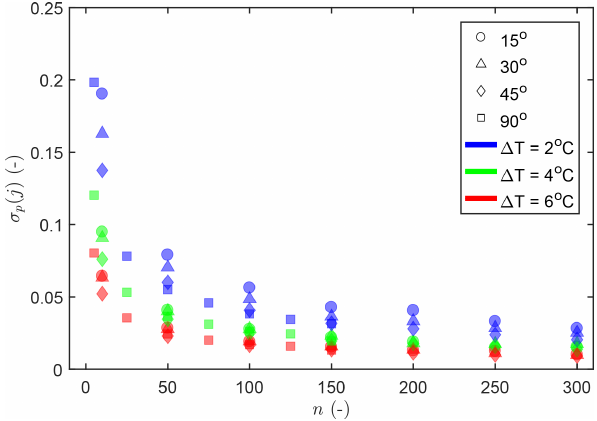
Figure 4. Bias in AHFO wind speed as a function of averaging period for different angles of attack and different fiber heating, with n varying from 5 to 300.